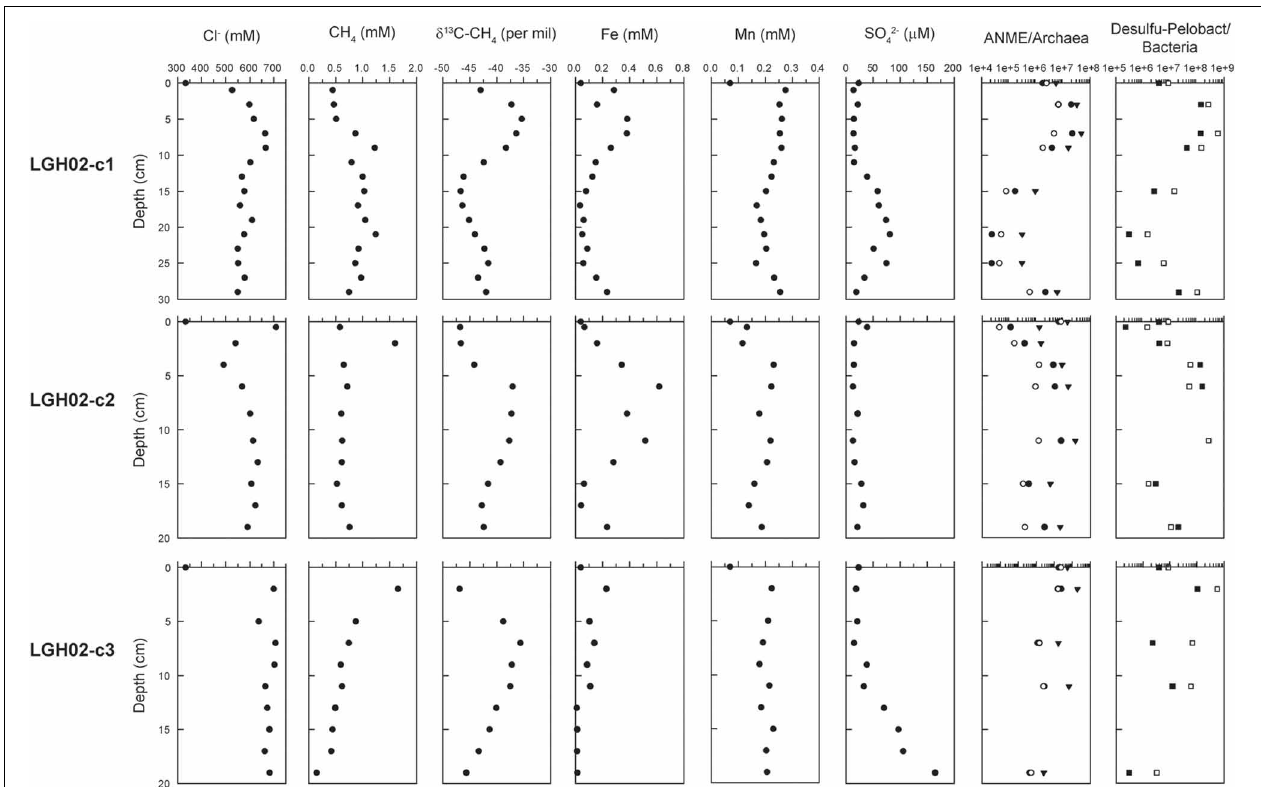
FIGURE 2 | Pore water geochemistry and 16S rRNA gene abundances along depth. Target taxonomic units for qPCR analyses include archaea (solid triangles), ANME-2a amplified by primers A426f (solid circles) and A426fm